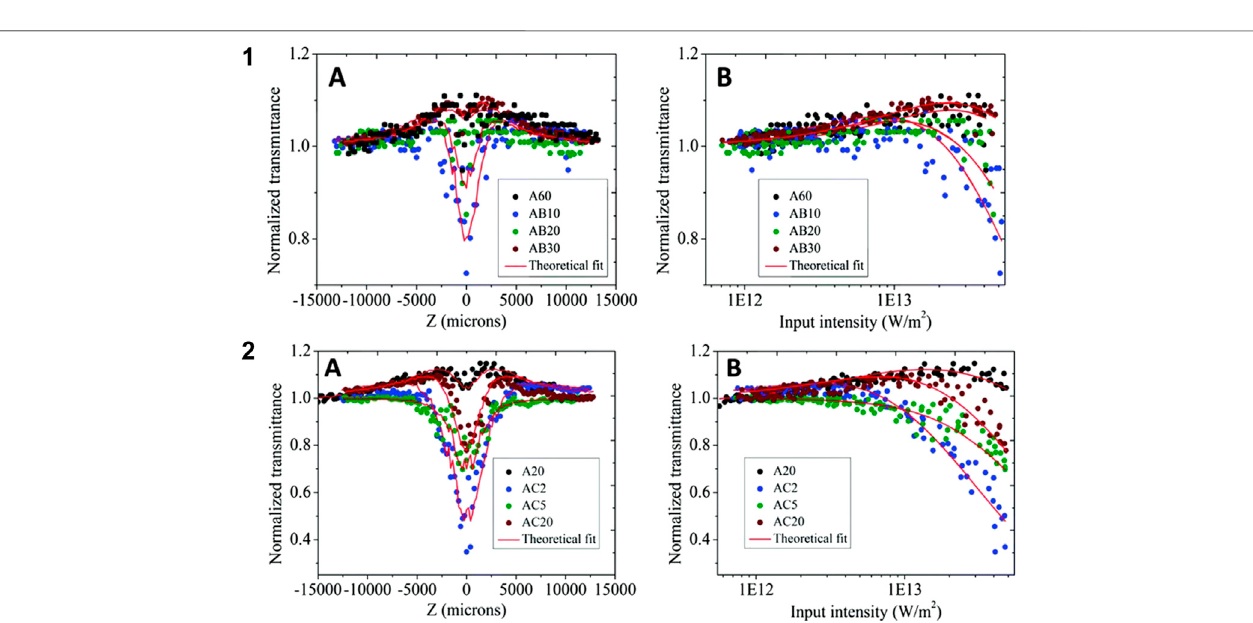
FIGURE 9 | (1) Various shell thickness CdSe/ZnS core-shell QDs measured curves, (2) Various shell thickness CdSe/CdS core-shell QDs measured curves (In fi gure legends thickness increases from top to bottom): (A) Z-scan open aperture curves. (B) Normalized optical transmission curves. Experimental data was shown by symbols while solid curves display numerical fi ts calculated via using the absorption coef fi cient equation [128]. “ Republished with permission of the Royal Society of Chemistry, from Ref. [128], copyright 2020; permission conveyed through Copyright Clearance Center, Inc.